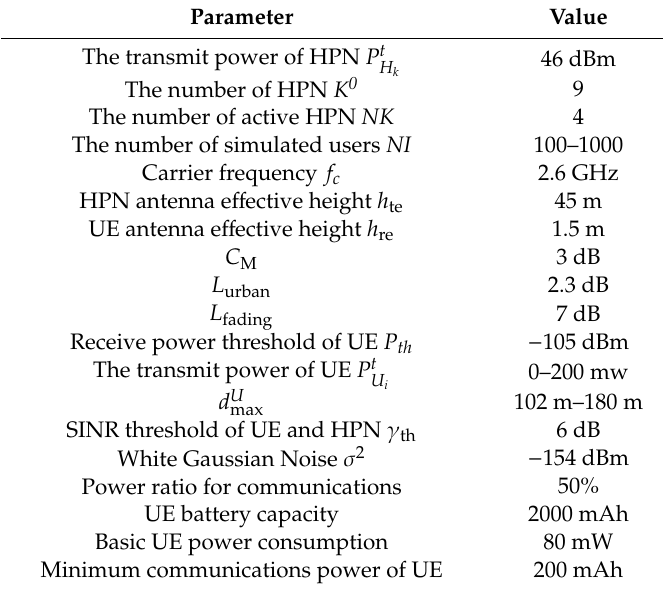
Table 3. The key parameters of